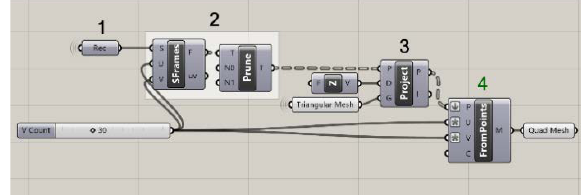
Figure 4. Macro to transform in structured quad-mesh